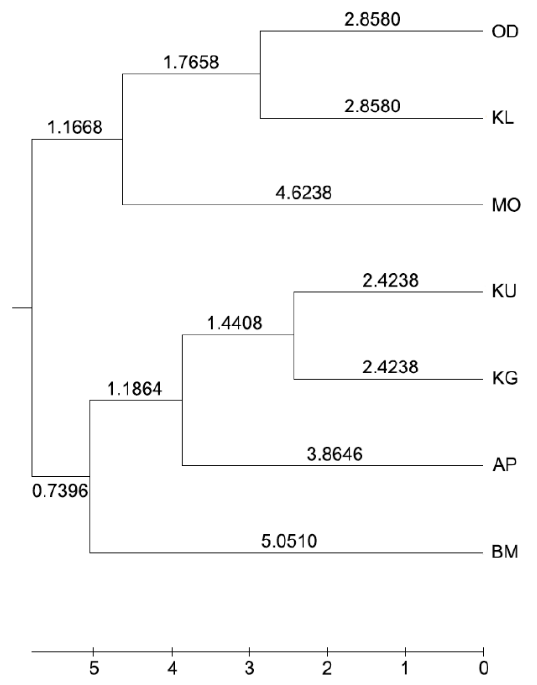
Figure 4. UPGMA tree using Nei’s genetic distance. Bootstrap values are presented at the branch